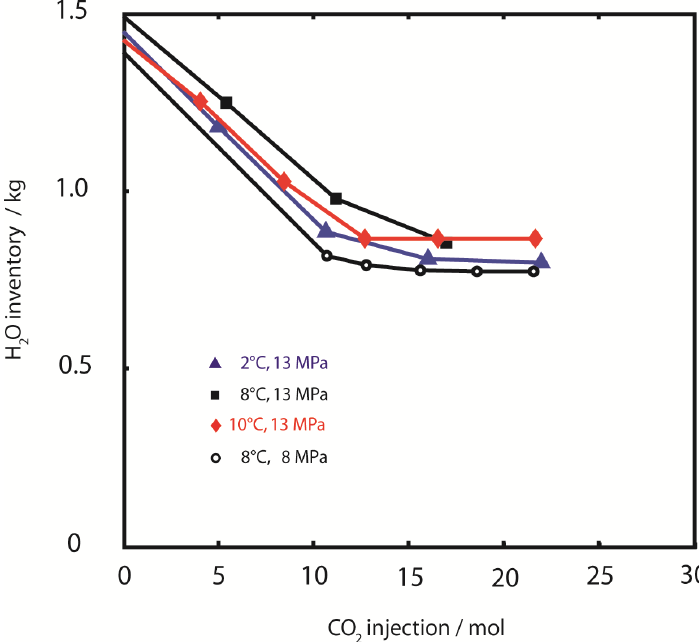
O sample inventory during injection of CO Figure 6. Water retention. H 2 pore water was similar for all experiments with approximately 50% of initial water content (pore water plus hydrate water) being